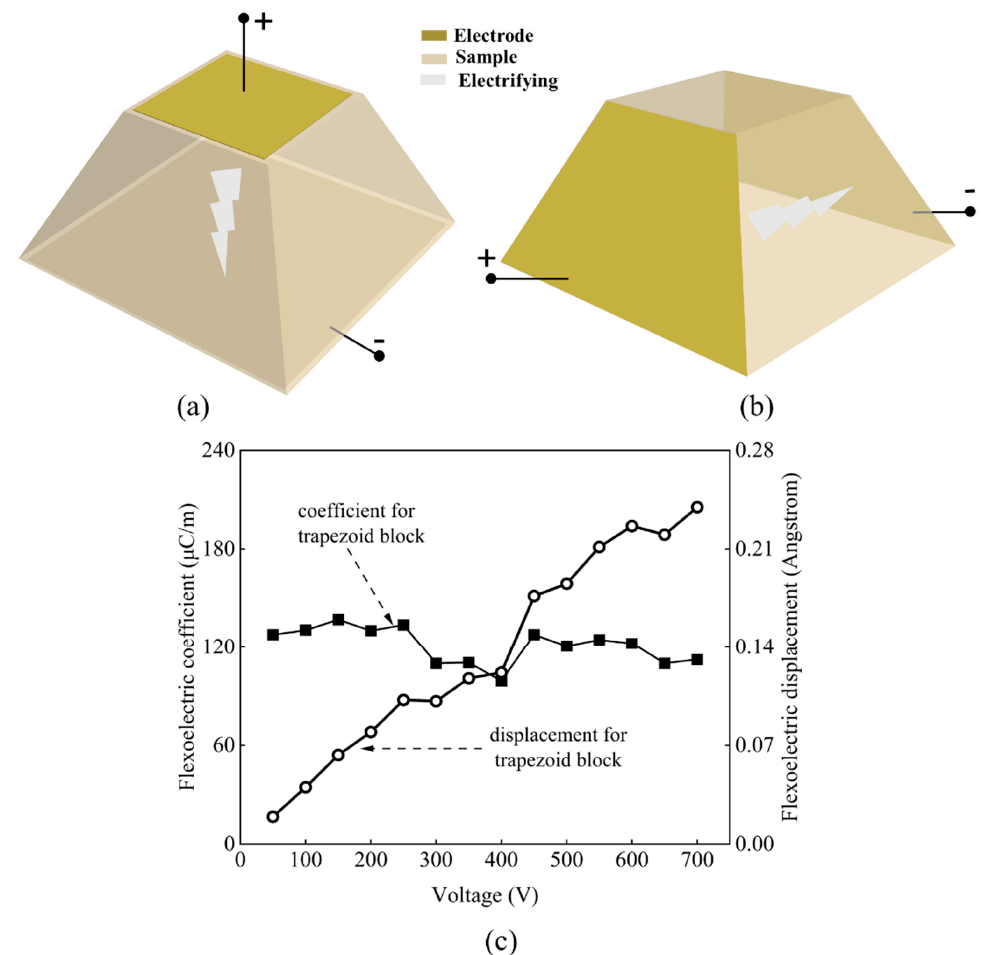
Figure 8. Schematic of converse flexoelectric coefficient measurement by applying a voltage on ( a ) top and bottom surfaces, or ( b ) both lateral sides of the truncated pyramid-like samples. ( c ) Flexoelectric coefficient and displacement of the trapezoid BST block measured by the converse flexoelectric effect at 25 ◦ C under ac drive voltages with a frequency of 400 Hz. Reprinted with permission from [33]. Copyright 2006 AIP Publishing.